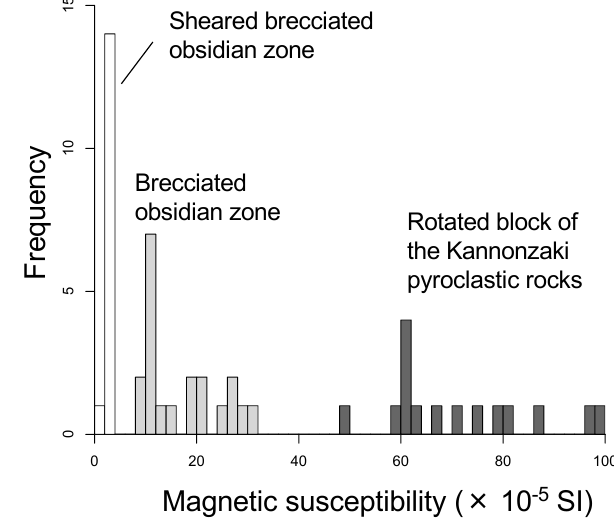
Figure 17: Results of the magnetic susceptibility of the matrices of the sheared brecciated obsidian, brecciated obsidian zones, and the adjacent Kannonzaki pyroclas- tic